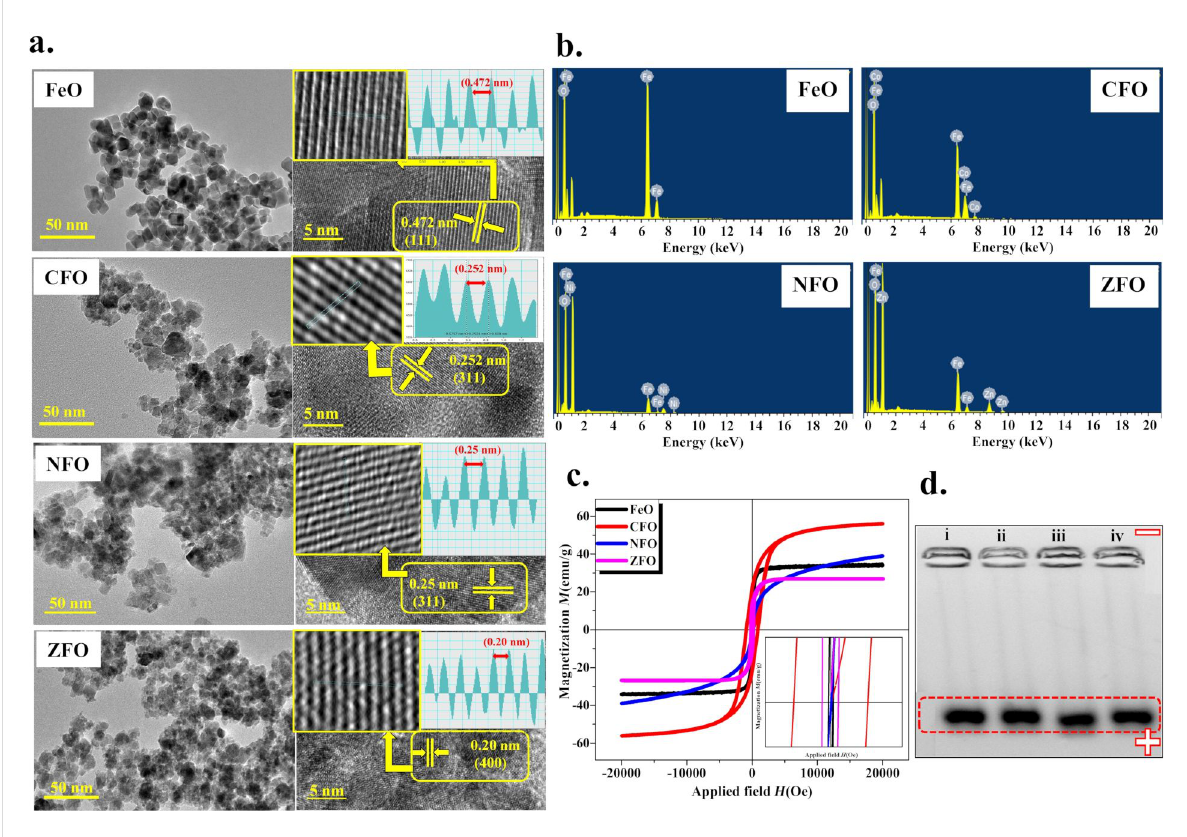
Figure 2: (a) HR-TEM micrographs of MFe 2 O 4 (M = Fe, Co, Ni, Zn) NPs showing the respective planes. (b) EDS analysis showing major elemental composition in synthesized NPs. (c) Magnetization as a function of the applied field on NPs at room temperature at an applied field of 2.0 T. (d) Agarose gel electrophoresis image of (i) FeO-PMA, (ii) NFO-PMA, (iii) CFO-PMA, and (iv) ZFO-PMA NPs. The black bands on the gel indicate a uniform size distribution and a negative surface charge on colloidal NPs.